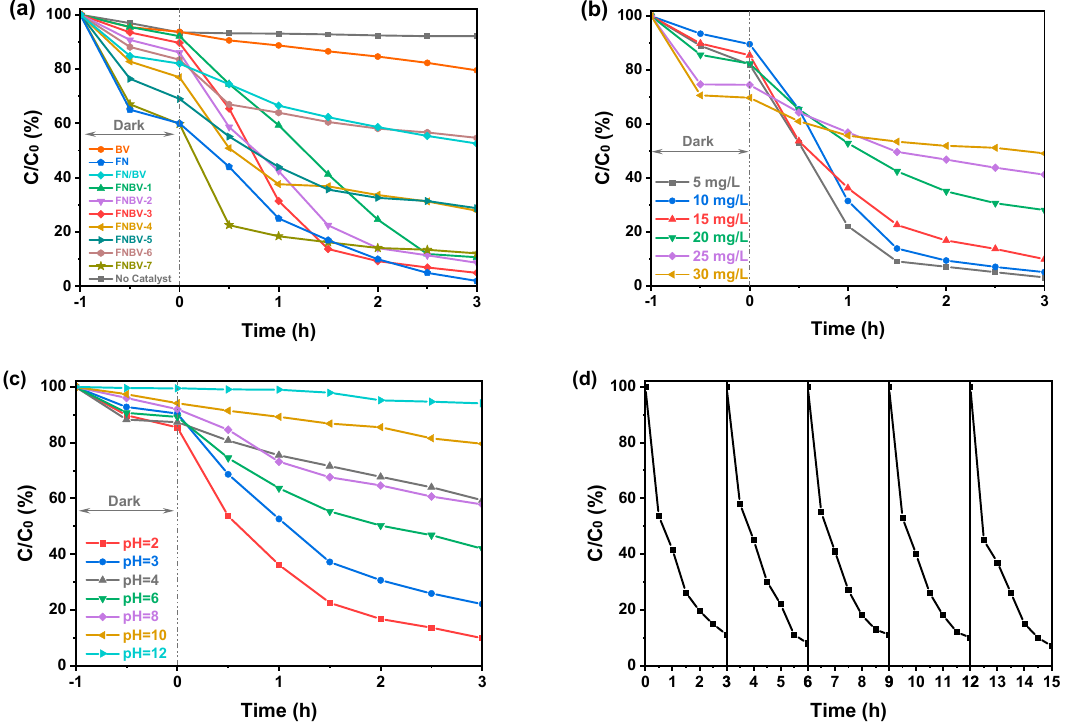
Figure 4. ( a ) Photocatalytic reduction of 10 mg·L − 1 Cr(VI) solution via the preparation; effect of Cr(VI) concentration ( b ) and pH value ( c ) on the reduction over FNBV–3; ( d ) recycling test for photocatalytic reduction of 15 mg·L − 1 Cr(VI) solution. Reaction conditions: 1g·L − 1 , λ > 420 nm, room temperature.